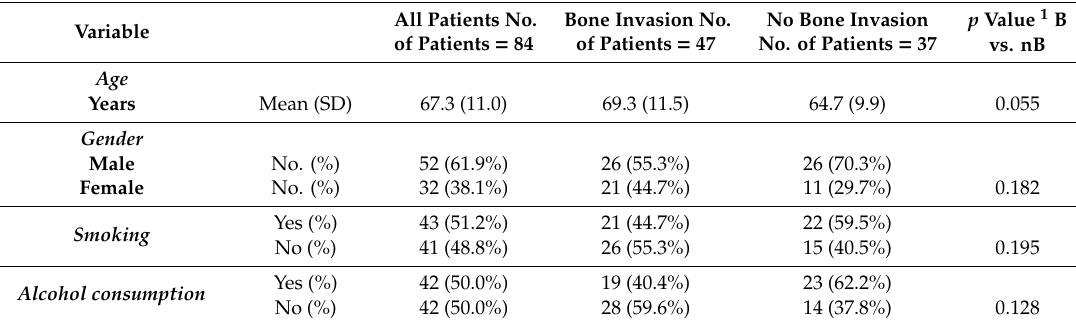
Table 1. Patient Demographics and Clinical